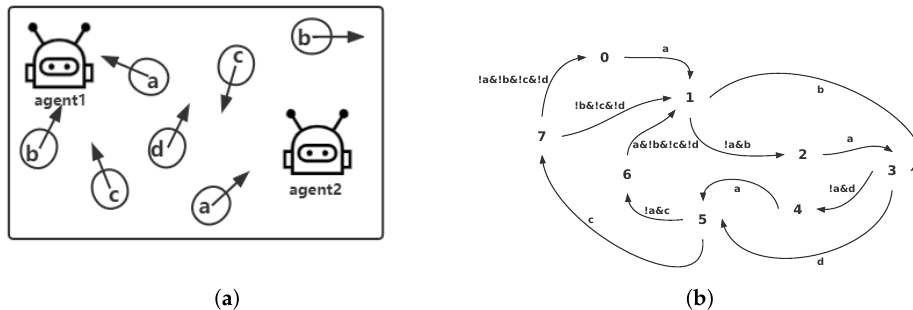
Figure 1. Example showing motion planning under a stochastic environment. ( a ) Motion planning under stochastic environment. ( b ) Synthesized strategy of the example.